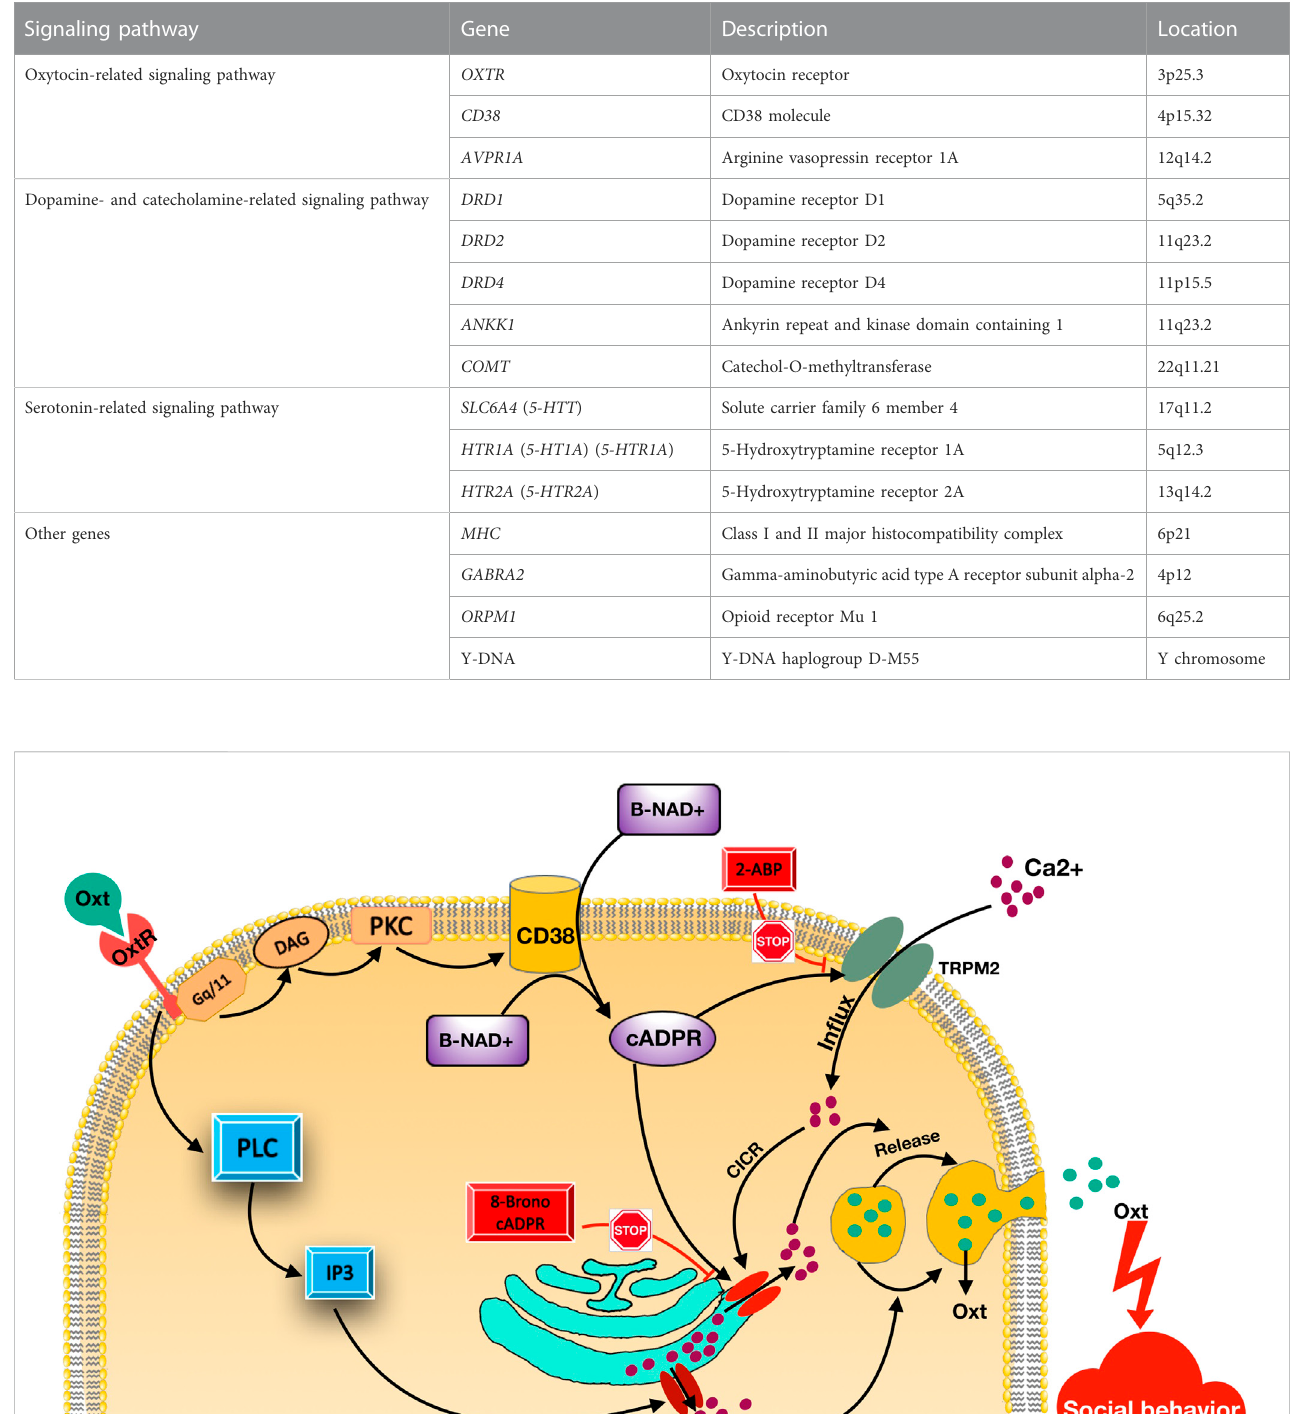
TABLE 2 Different evaluated genes or chromosomal regions.